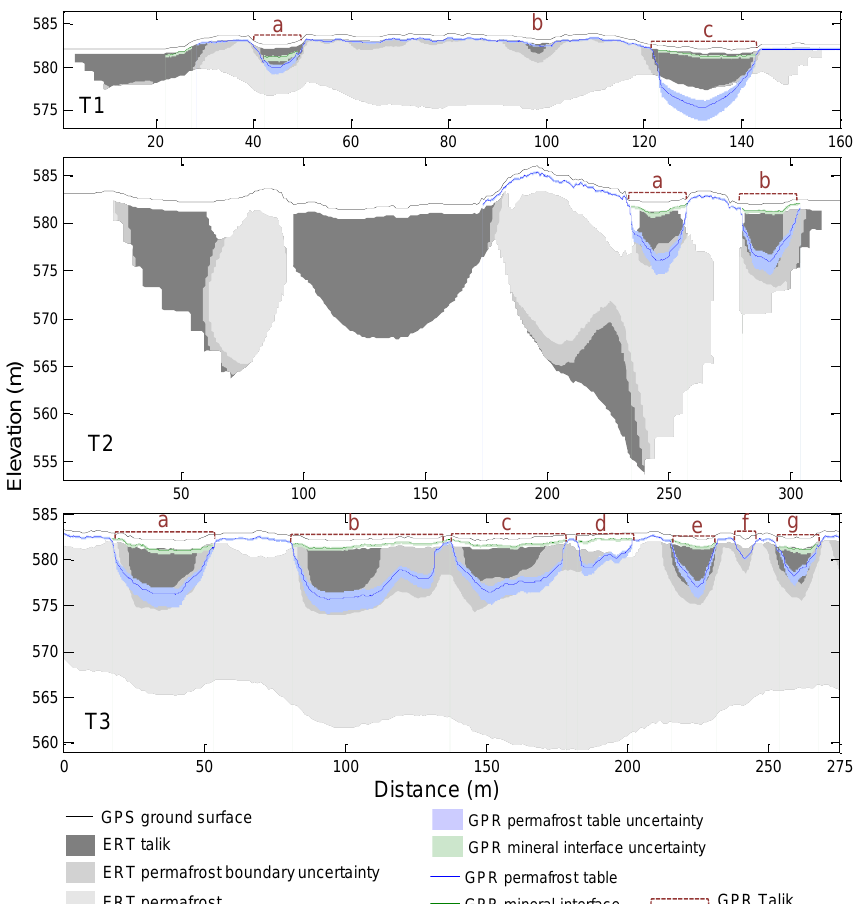
Figure 6. Interpreted permafrost distribution along T1, T2, and T3. Uncertainty intervals come from the range of estimated signal velocities for GPR (Table 1) and from the range of resistivity values (1000–1700 (cid:127) m) used for identifying the permafrost boundary for ERT. In sections marked GPR Talik (red dotted line), GPR depth conversions have been made using saturated peat velocities down to the peat–mineral interface (green line) and then using saturated mineral substrate velocities down to the permafrost table (blue line). In the remaining parts of transects, the dry peat velocities have been used down to the permafrost table. No interpretations of ERT data with DOI > 0.1 have been made and therefore the permafrost base is only visible along parts of T2. Note the differences in scale in the x direction between figures and the vertical